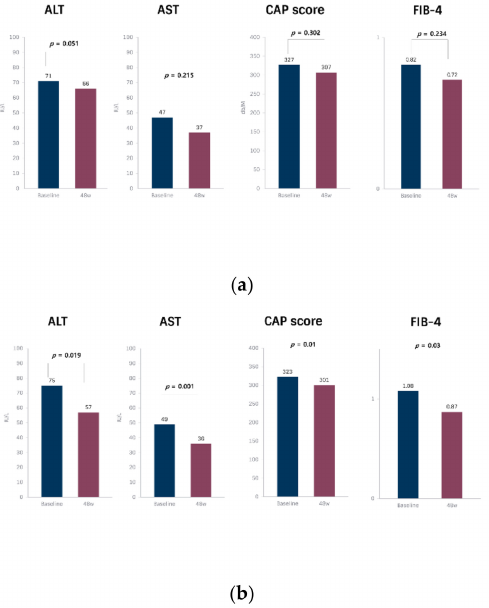
Figure 2. Within patient paired analysis in variables at 48 weeks from baseline within each group. ( a ) Control group; ( b ) MNT